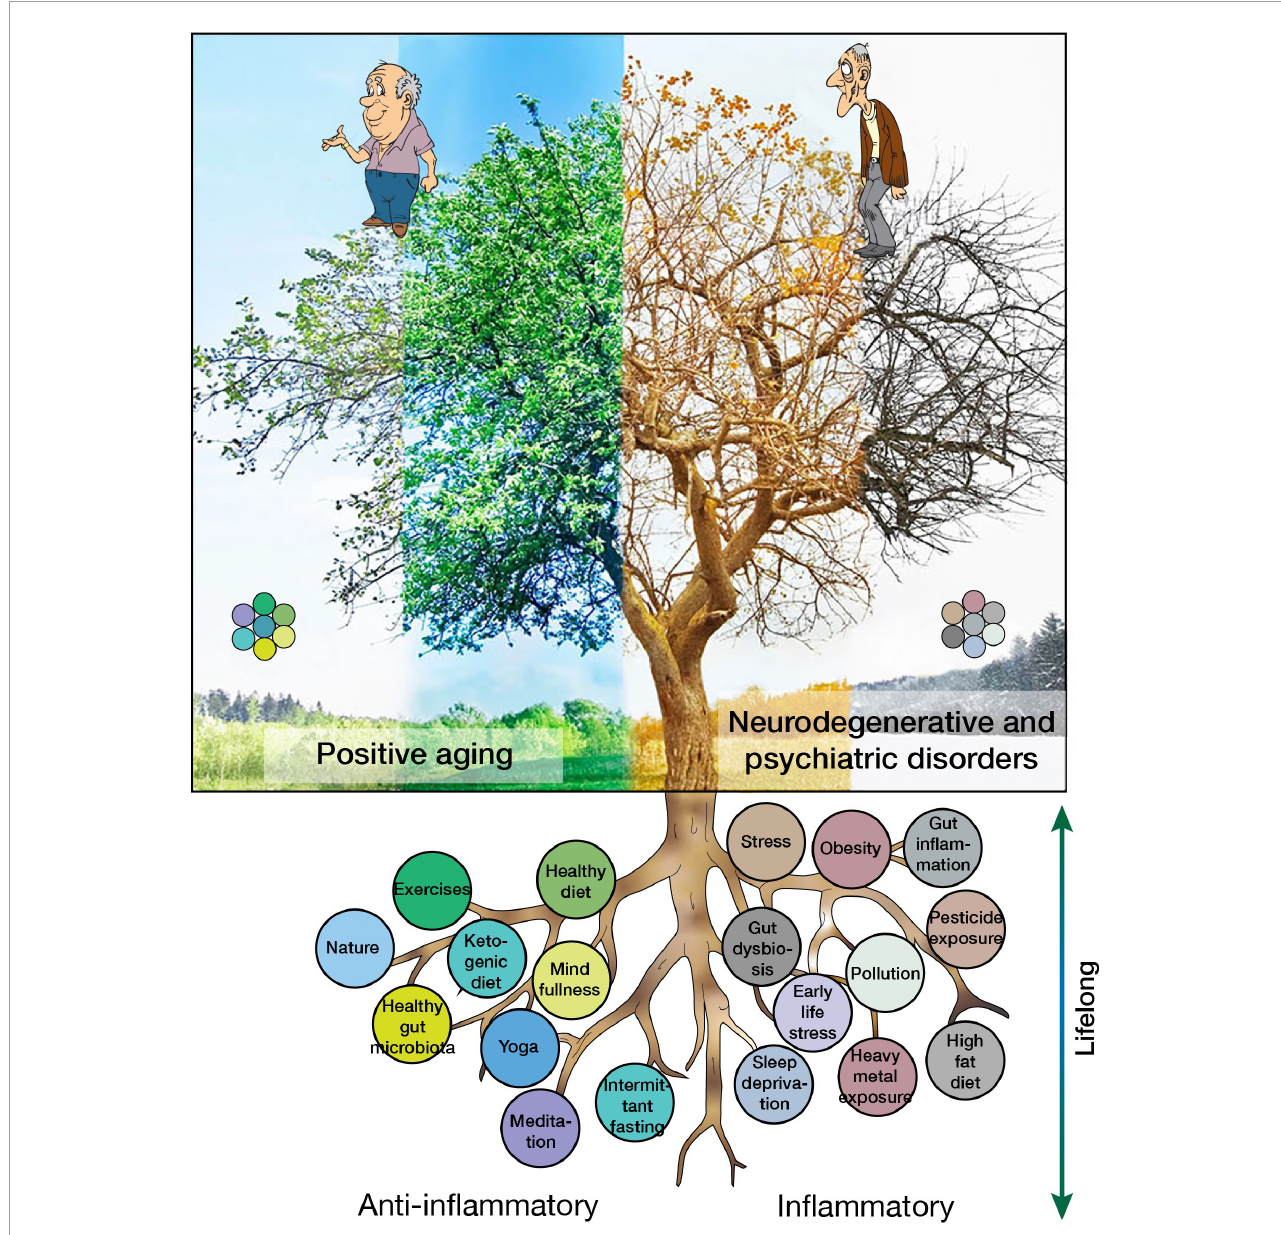
FIGURE4 Risk and protective factors for neuroinflammation and their contributions to positive aging or the development of neurodegenerative and psychiatric